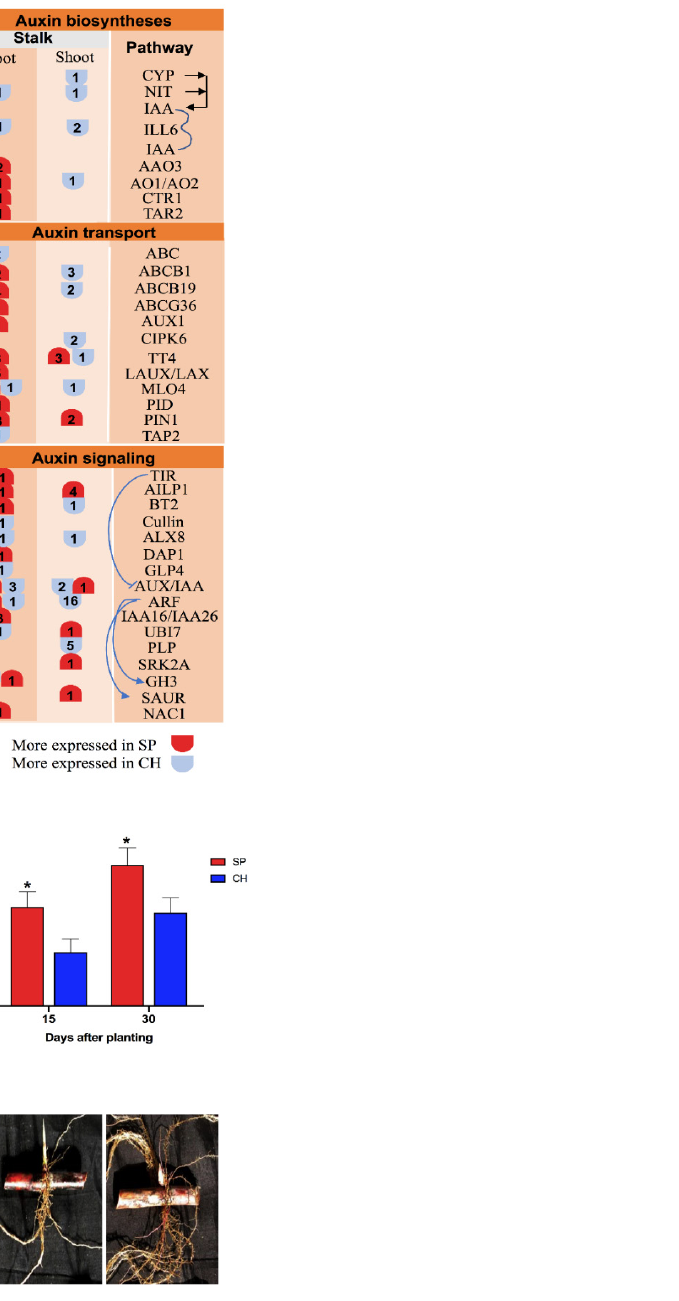
Figure 7. Evaluation of differential auxin pathway regulation between BNF-contrasting genotypes. ( a ) Schematic representation of auxin pathway showing the DET identified related to auxin bio- synthesis, auxin transporter and auxin signaling in roots and shoots of germinated stalks. In red are represented the transcripts more expressed in SP and in blue are represented the ones more ex- pressed in CH. ( b ) Evaluation of crown roots in the stalk plants (naturally colonized by endo- phytes). ( c ) Representative photos of germinated stalks 15 days after planting of CH (left) and SP (right) demonstrate the differences observed in the quantitative analysis. Bars represent mean ± standard deviation of three biological replicates. Asterisks (*) represent significant difference be- tween SP and CH at the same time point through t-test ( p < 0.05). Auxin signaling and response depends on its recognition by the intracellular re- ceptor of the Auxin Signaling F-BOX/Transport Inhibitor Response (AFB/TIR) family [82]. Through this interaction, AUX/IAA (Indole-3-acetic acid inducible), a repressor of